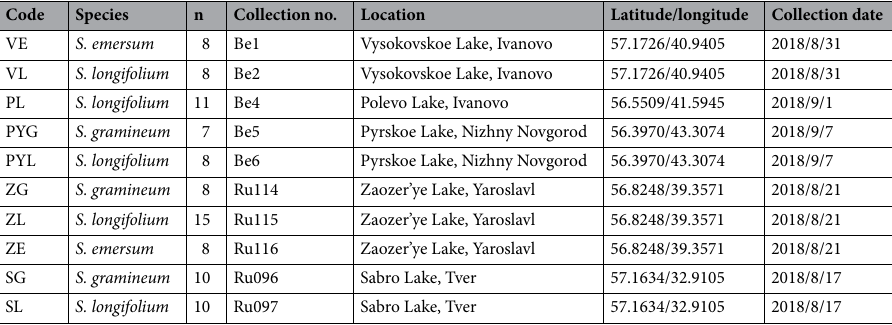
Table 1. Sampling sites and number of samples for Sparganium emersum , S. longifolium and S. gramineum